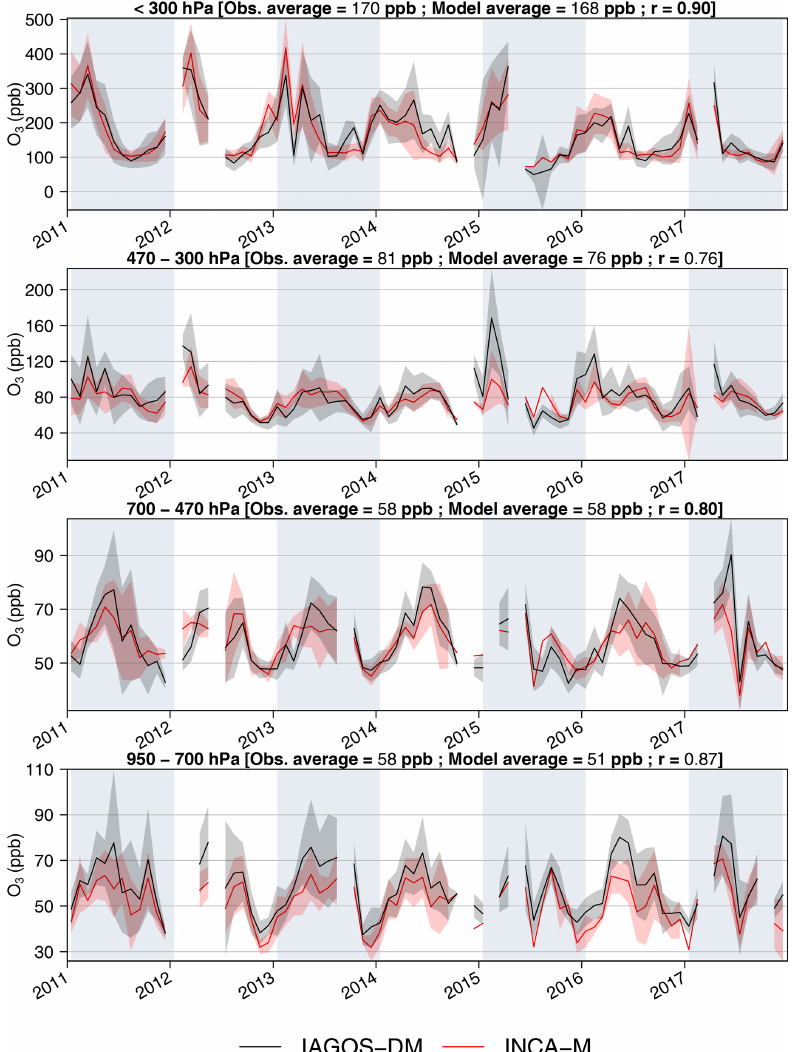
Figure 2. Ozone monthly mean values derived in four altitude domains representing the LMT, LFT, UFT, and UT-LMS (from bottom to top) from the gridded IAGOS data set (solid black line) and the simulation output (solid red line) over northeastern Asia, with respect to the IAGOS mask. The uncertainties are defined by the regional average of the standard deviations calculated for each grid cell. For each altitude domain, the yearly O 3 concentration derived from the mean seasonal cycle is indicated above the corresponding graphic for both data sets, with the Pearson correlation coefficient comparing the two monthly time